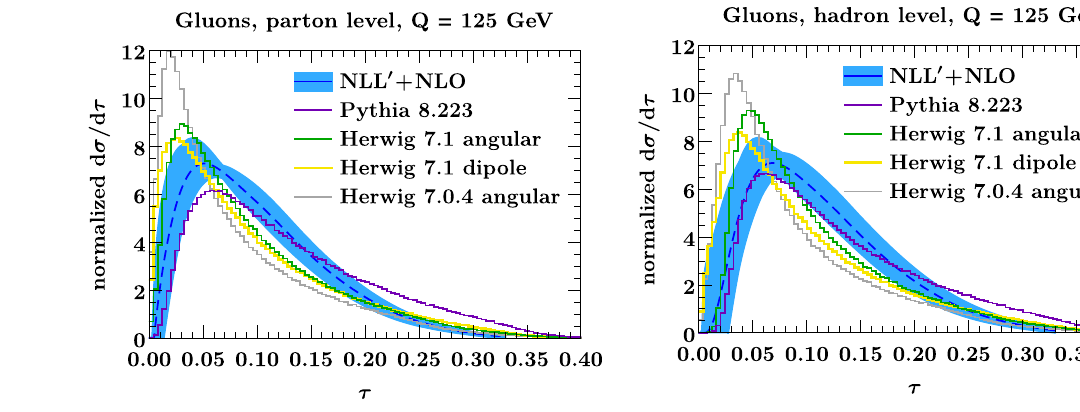
perturbative and nonperturbative uncertainties as in Eq. (17). The result fromtheangular-orderedshowerin Herwig 7.0.4isshowninlightgray, which differs significantly from the resummed results, highlighting the noticeable improvement in Herwig